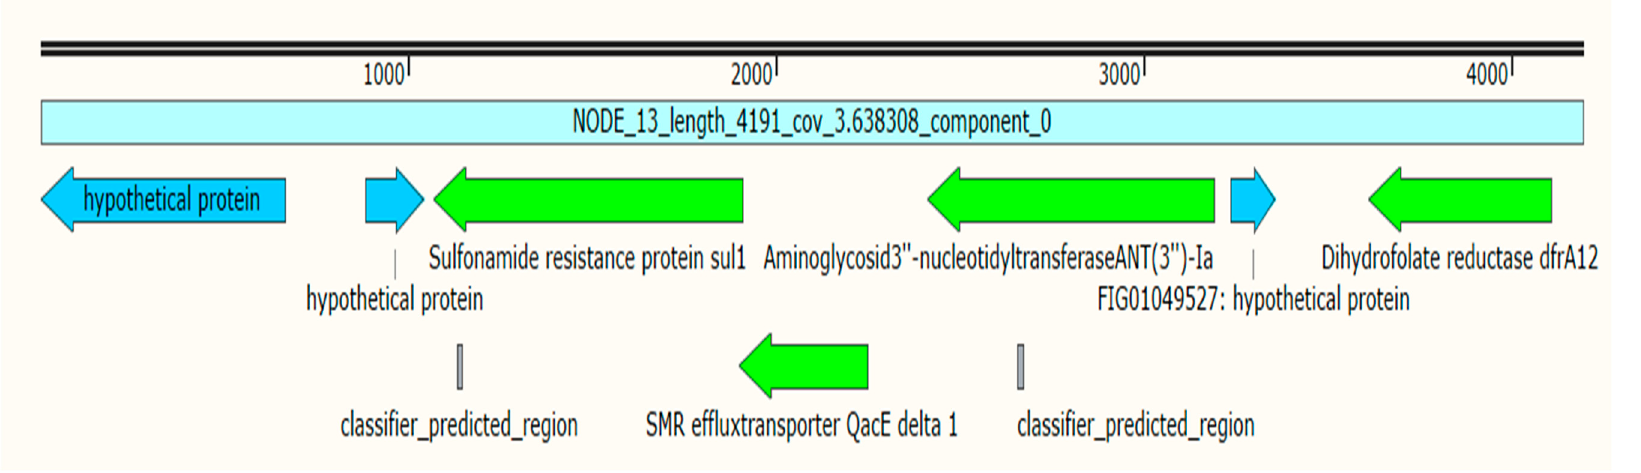
Figure 1. A cluster of antimicrobial resistance genes in the plasmid p CEX23 of isolate K6. The green colors represent the sulphonamide-resistant gene ( sul2 ), disinfecting agents and antiseptic-resistant gene ( qacE ), trimethoprim-resistant gene ( dfrA12 ), and the aminoglycoside-resistant gene ( aadA2 ).